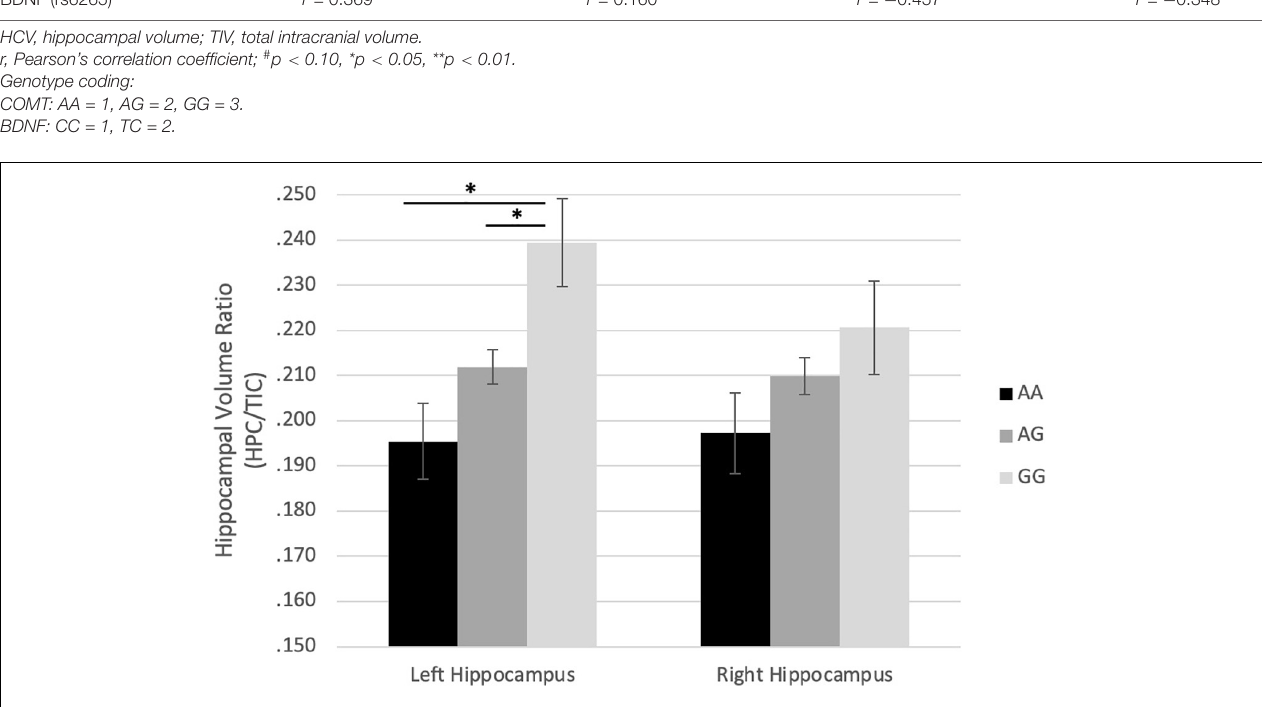
Frontiers in Behavioral Neuroscience |